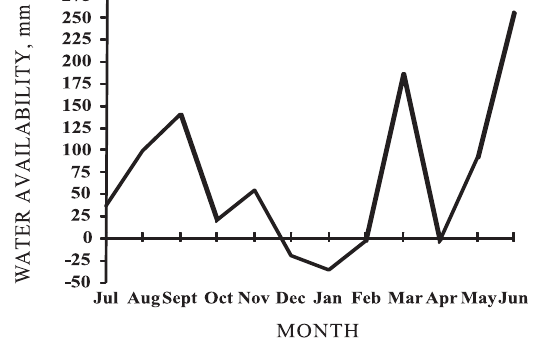
Figure 1. Hydric balance for water storage capacity in the soil 50 mm, in the period in which experiment was held, EEA/UFRGS, 2006/2007 growing